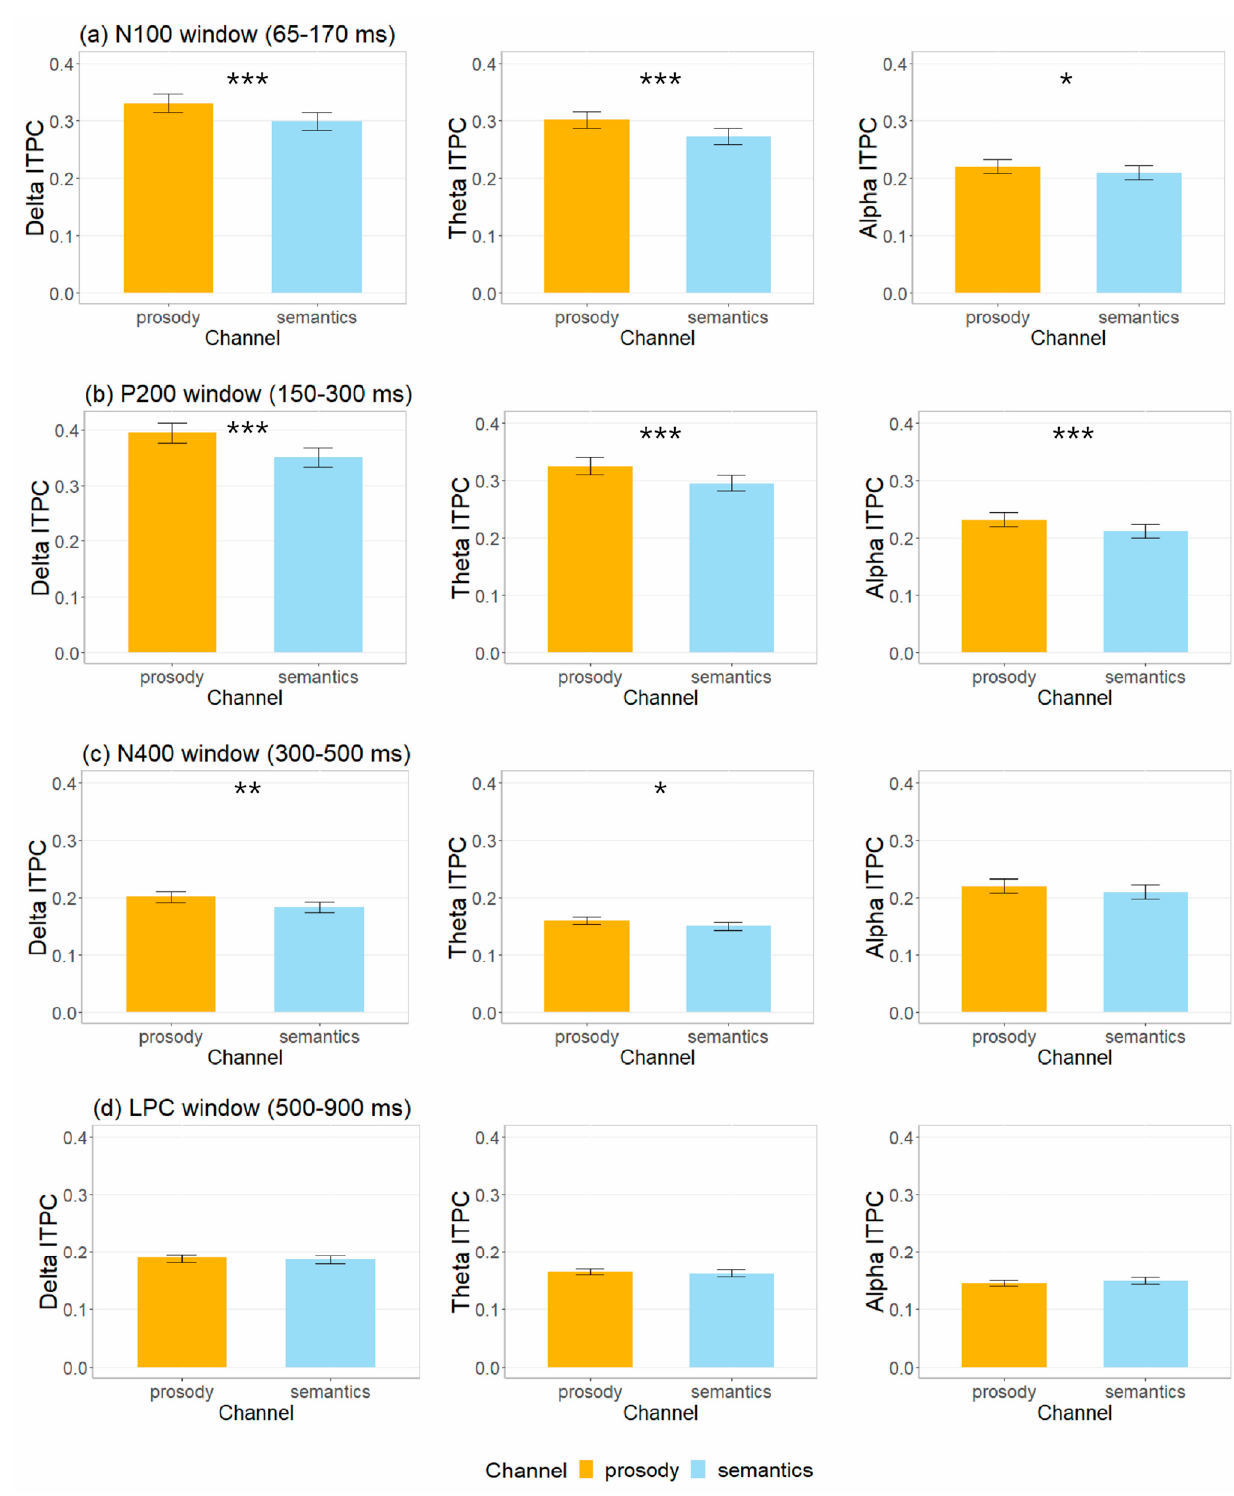
Figure 5. Bar plots of delta, theta and alpha ITPC associated with ( a ) N100, ( b ) P200, ( c ) N400 and (d) LPC for prosodic and semantic channels. Mean phase locking value is displayed in the bar charts with error bars showing 95% confidence intervals. Asterisks mark the significance level: * p < 0.05; ** p < 0.01; *** p < 0.001. N100. In the N100 window, LME analyses on delta and theta ITPC showed main effects of channel (delta: χ 2 (1) = 22.07, p < 0.001; theta: χ 2 (1) = 24.67, p < 0.001),